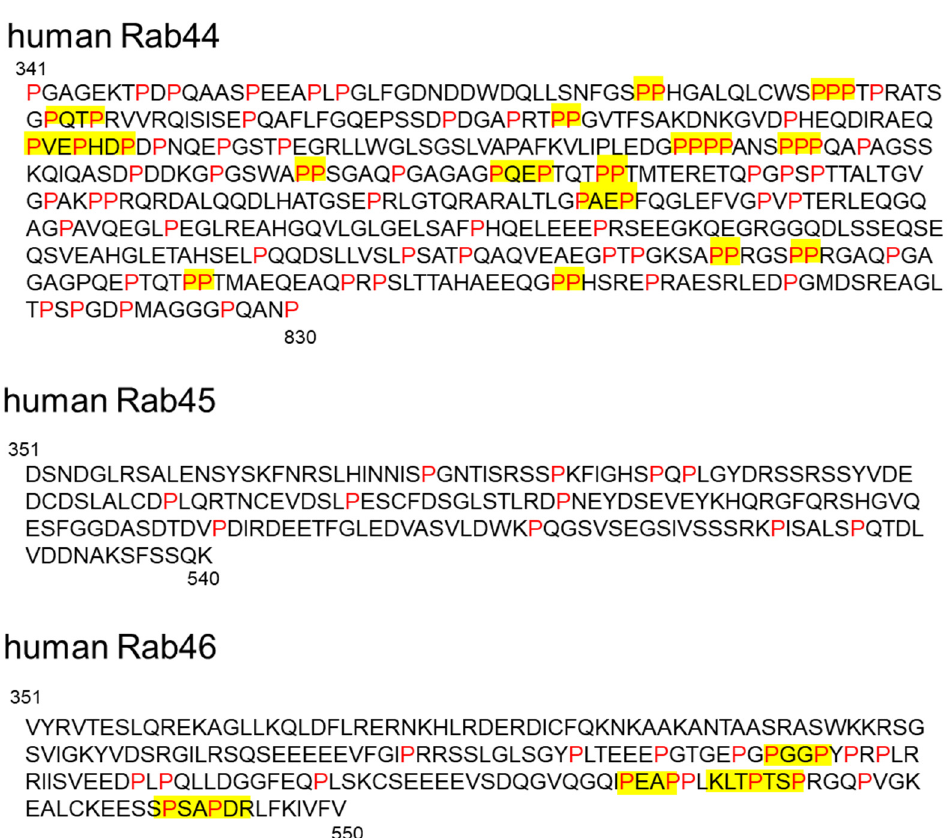
Figure 2. Sequence alignment of regions between the coiled-coil domain and the Rab domain in large Rab GTPases. The red letters indicate proline residues. Yellow indicates proline-rich sequences, including PxxPxxP, PPxPPxPP, PxxP, (R/K)xxPxxP, PxxPx(R/K), and xPPx. Accession numbers for the proteins are the following: human Rab44 (NP_001244286.1), human Rab45/RASEF (NP_689786.2), and human Rab46 (NP_001138430.1).